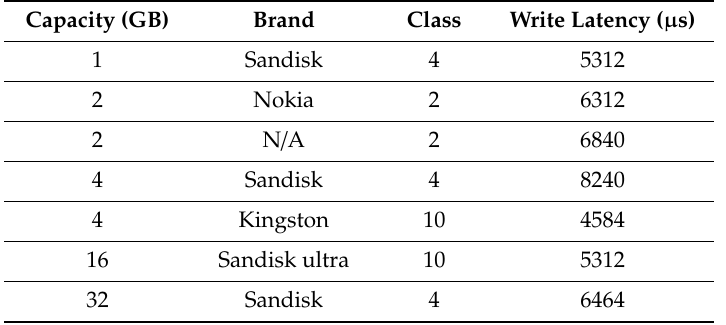
Table 13. Write latency measurement in Classes 2, 4, and 10 microSD memory